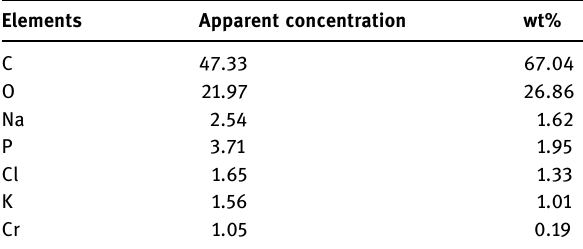
Table 1: Elemental content in chromate - tolerant bacterium UT8 grown in LB broth supplemented with 1,500 μ g/mL chromium ( VI )